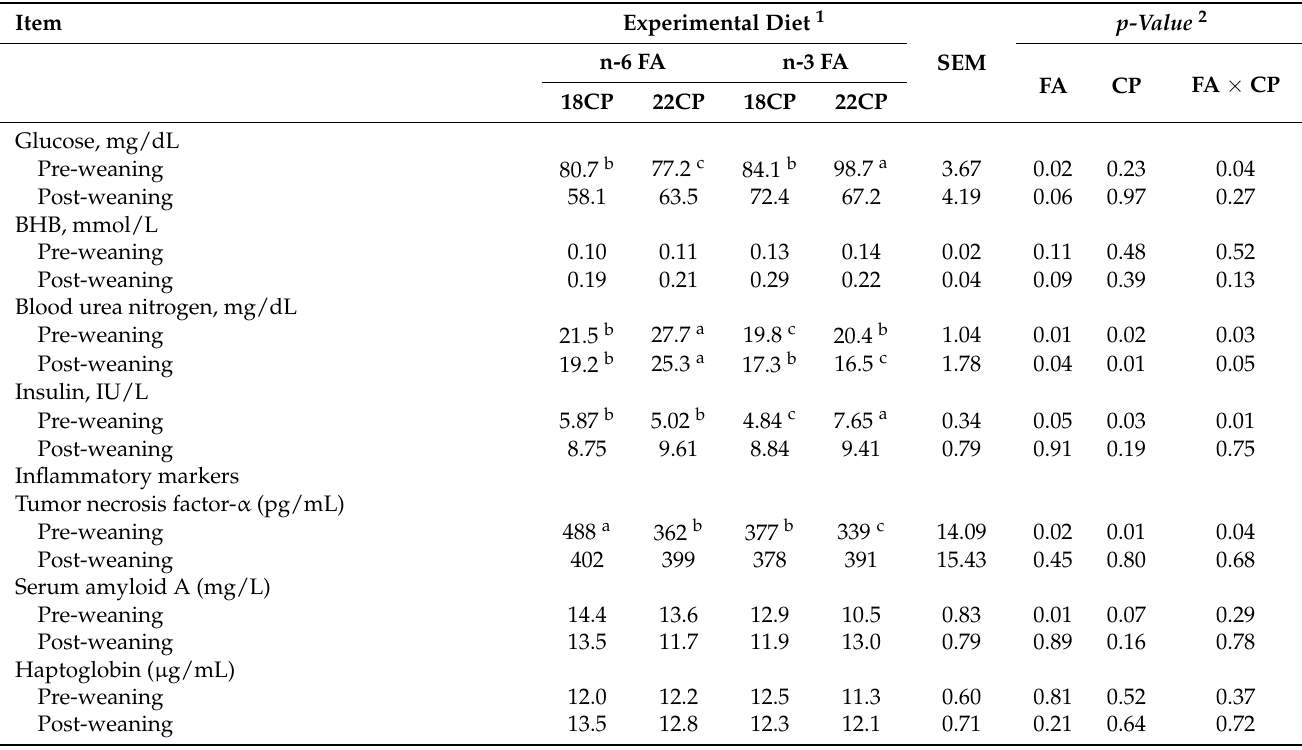
Table 4. Least square means for blood metabolites in dairy calves fed different FA sources (Ca salt of n-6 FA source vs. Ca salt of n-3 FA source) and starter CP content (18 vs. 22%, DM basis) ( n = 10 calves per